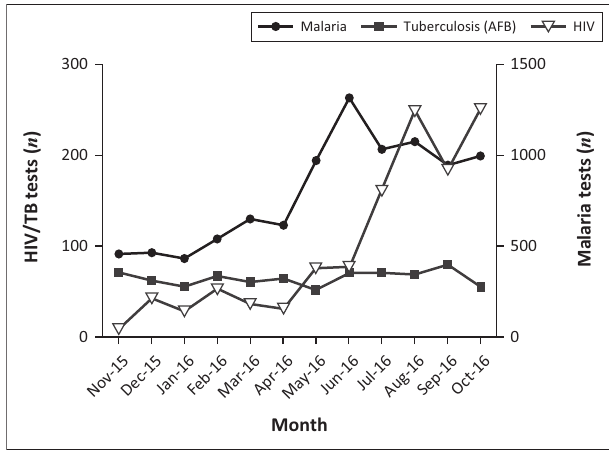
FIG URE 3: Testing volumes of HIV, tuberculosis and malaria by month, Koidu Government Hospital central laboratory, Sierra Leone, November 2015–2016. Number of tests performed per month for HIV (open triangles, left y-axis), tuberculosis (AFB, closed squares, left y-axis) and malaria (closed circles, on right